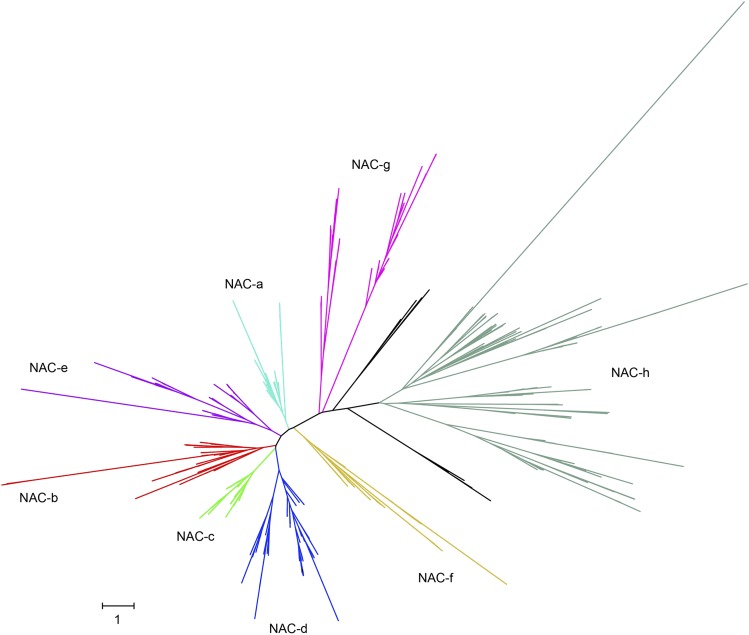
Maximum likelihood phylogeny of 667 NAC proteins from wheat, rice, and barley. The phylogeny was constructed using only the NAC domain. NAC groups a–h were assigned according to rice and barley orthologs. In cases where the group assigned to a rice or barley gene conflicted with the overall tree topology, no group was assigned (black branches). Details of individual genes are presented in Figure S1 and Table S4.